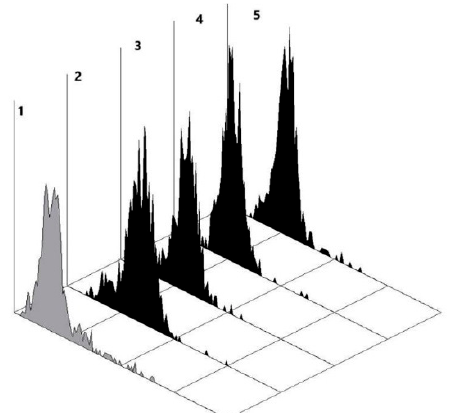
Figure 2. Interaction of human antibodies affinity-isolated using Le C -Sepharose with ZR 75-1 cells (at their max density), flow cytometry data (Cytomics FC 500 Beckman Coulter). The concentration of anti-Le C antibodies was 5 µg/mL (1 µg per 10 6 cells). Cells detached from a monolayer were immediately analyzed using flow cytometry: zone 1 , control (no anti-Le C Abs, MFI 0.55); zone 2 , 20 min of incubation with anti-Le C antibodies (95% of positive cells, MFI 1.3); zone 3 , 40 min of incubation with anti-Le C antibodies (95% of positive cells, MFI 1.4); zone 4 , 60 min of incubation with anti-Le C antibodies (96% of positive cells, MFI 1.5); zone 5 , 120 min of incubation with anti-Le C antibodies (87% of positive cells, MFI 2.3).